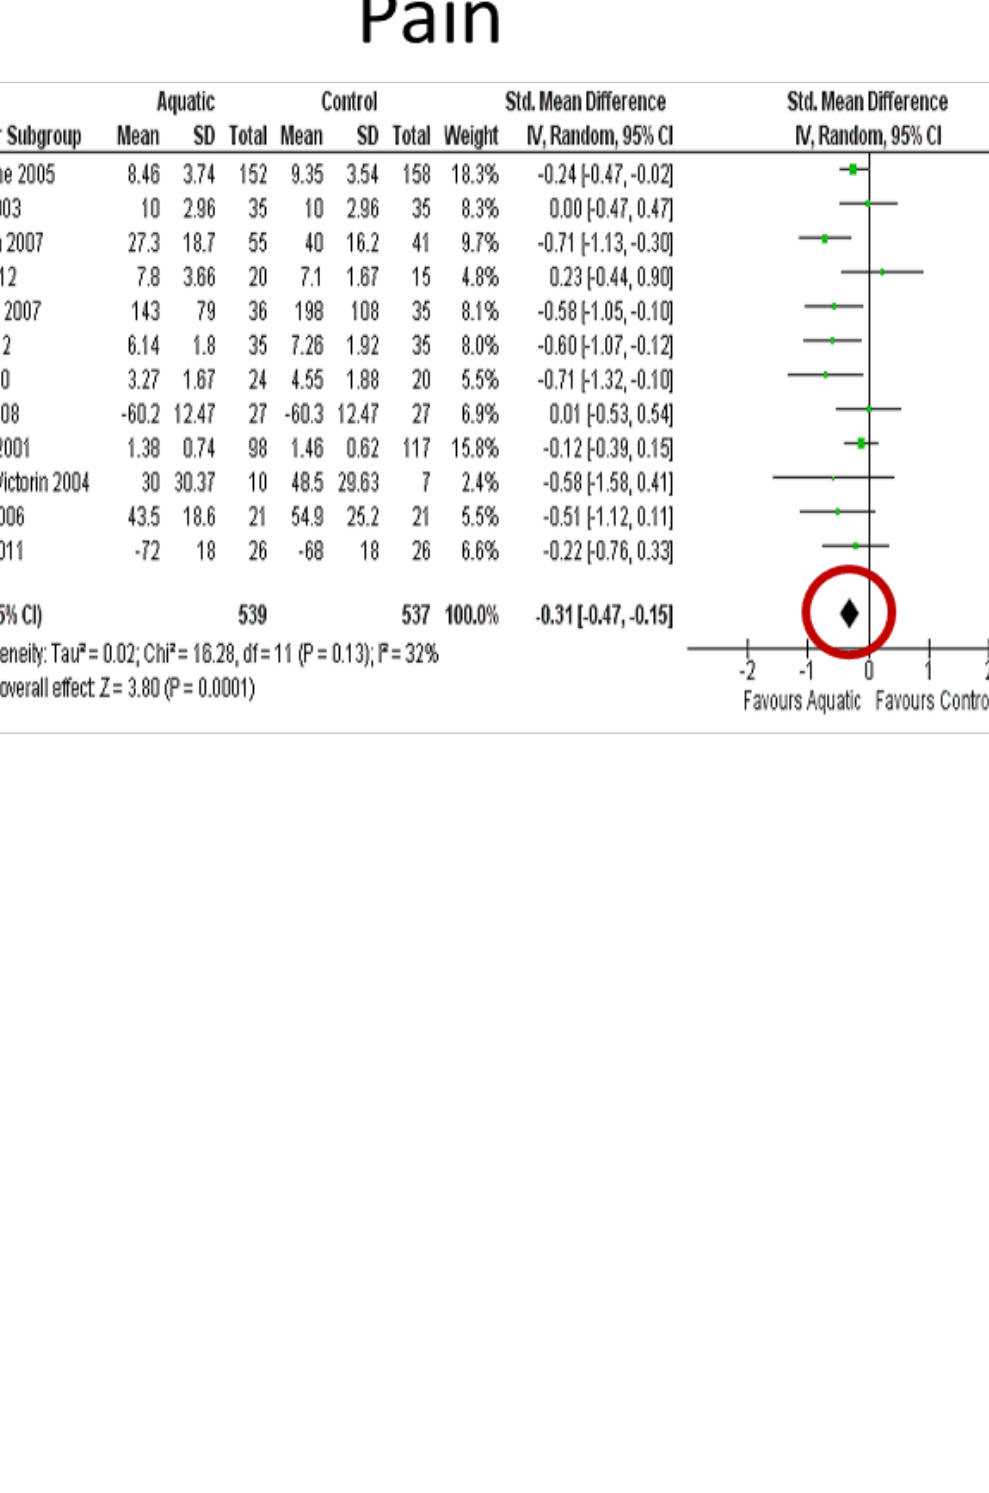
Figure F10-3. Effects of Aquatic Exercise on Pain, Physical Function, and Quality of Life in Knee